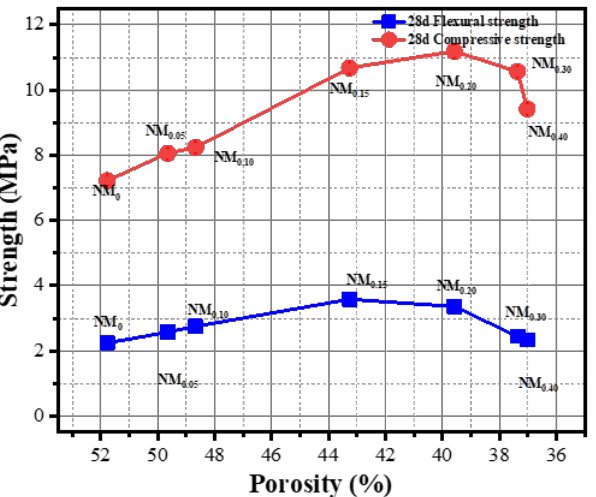
Figure 16. Corresponding relationship between porosity and strength of CHF foam concrete.